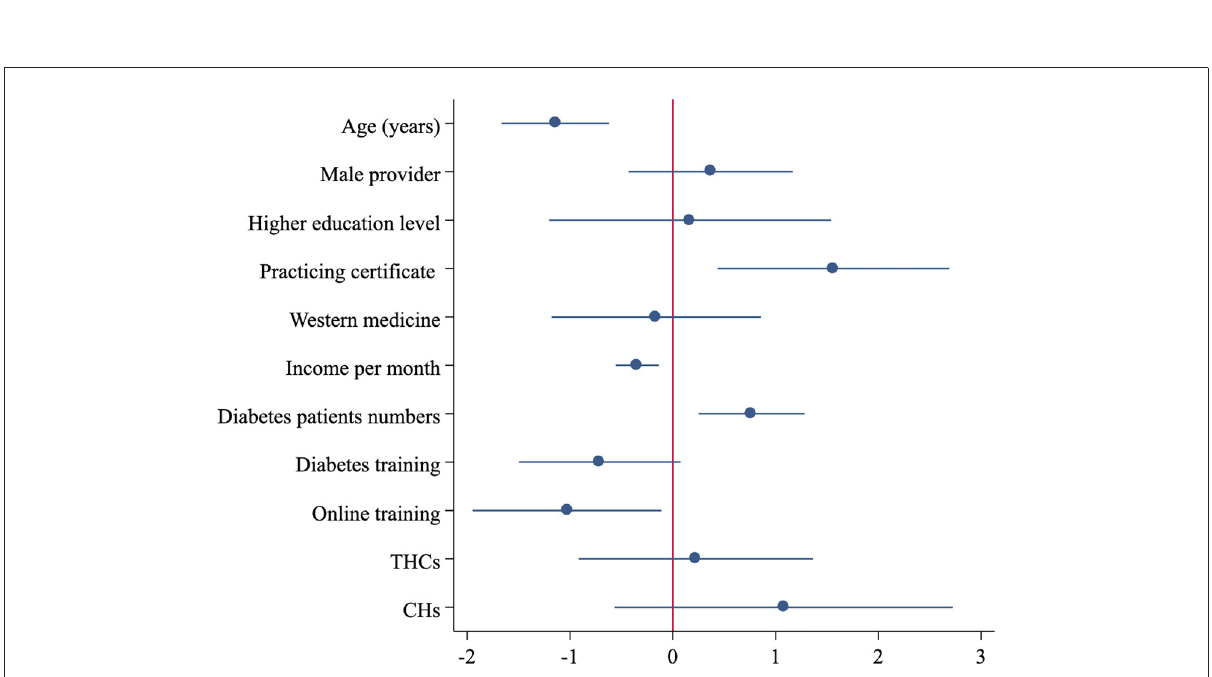
FIGURE4 Associated factors for correct treatment of type 2 diabetes among rural clinicians. Source: Author’s survey. NRQE, number of recommended questions and examinations; CH, County Hospital; THC, Township Health Center.